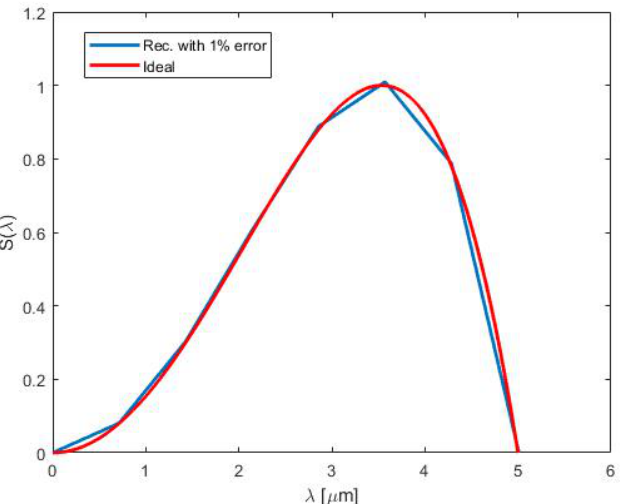
Figure A4. Reconstruction of the spectral response function with Laguerre polynomials compared to the 1% voltage error case.